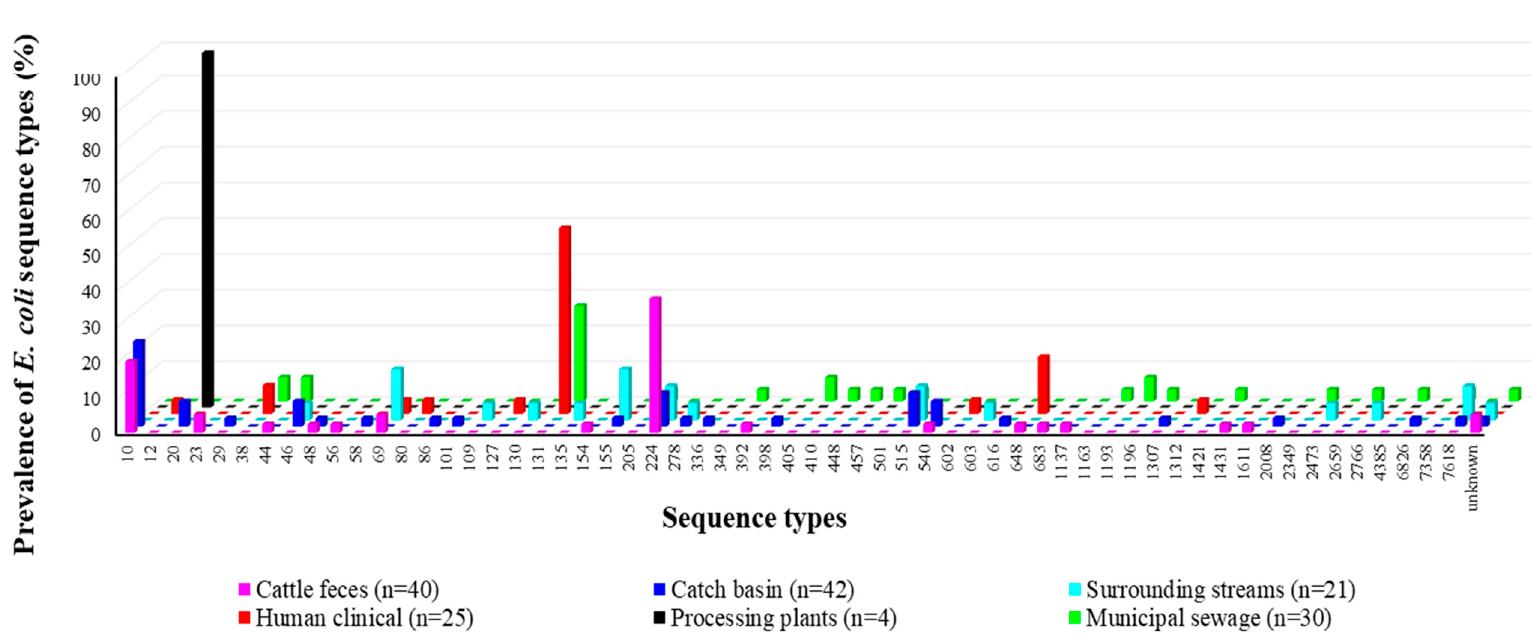
Figure 6. Percentage prevalence of specific sequence types (ST10 to ST7618 and unknown STs) identified in multiple segments of the One Health continuum using the E. coli Achtman scheme.